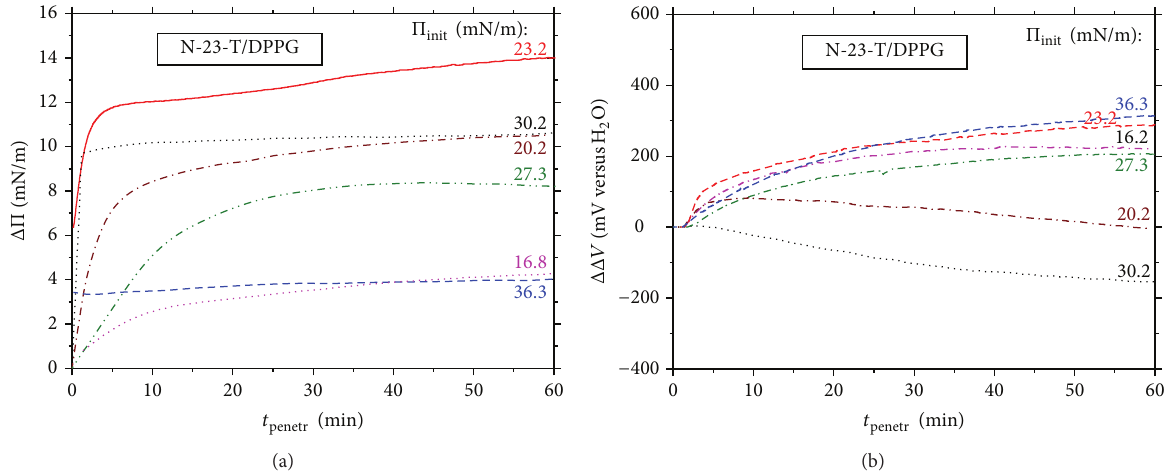
Figure 5: Time evolution of the effects on (a) surface pressure ( ΔΠ ) and (b) electric surface potential ( ΔΔ𝑉 ) caused by penetration of lactophoricin-I (N-23-T) to DPPG monolayer under stationary diffusion conditions; the courses registered at various initial densities of (denoted therein). The peptide’s concentration is 1 𝜇 pure DPPG monolayer are characterized by the initial surface pressure values, Π init